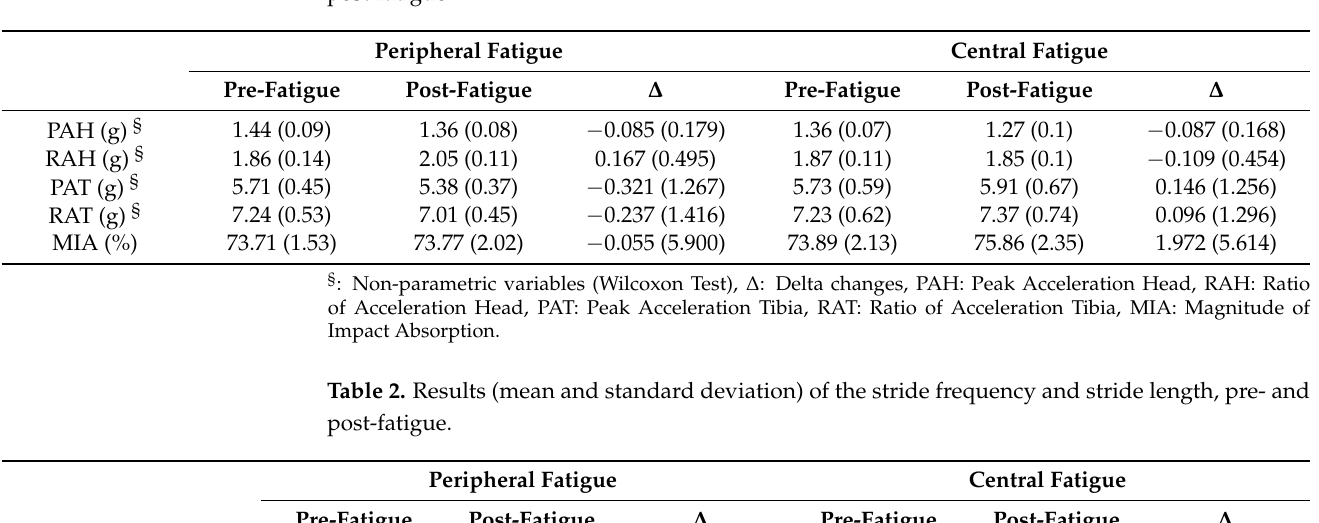
Table 1. Results (mean and standard deviation) of the impacts in the time-domain analysis, pre- and post-fatigue.